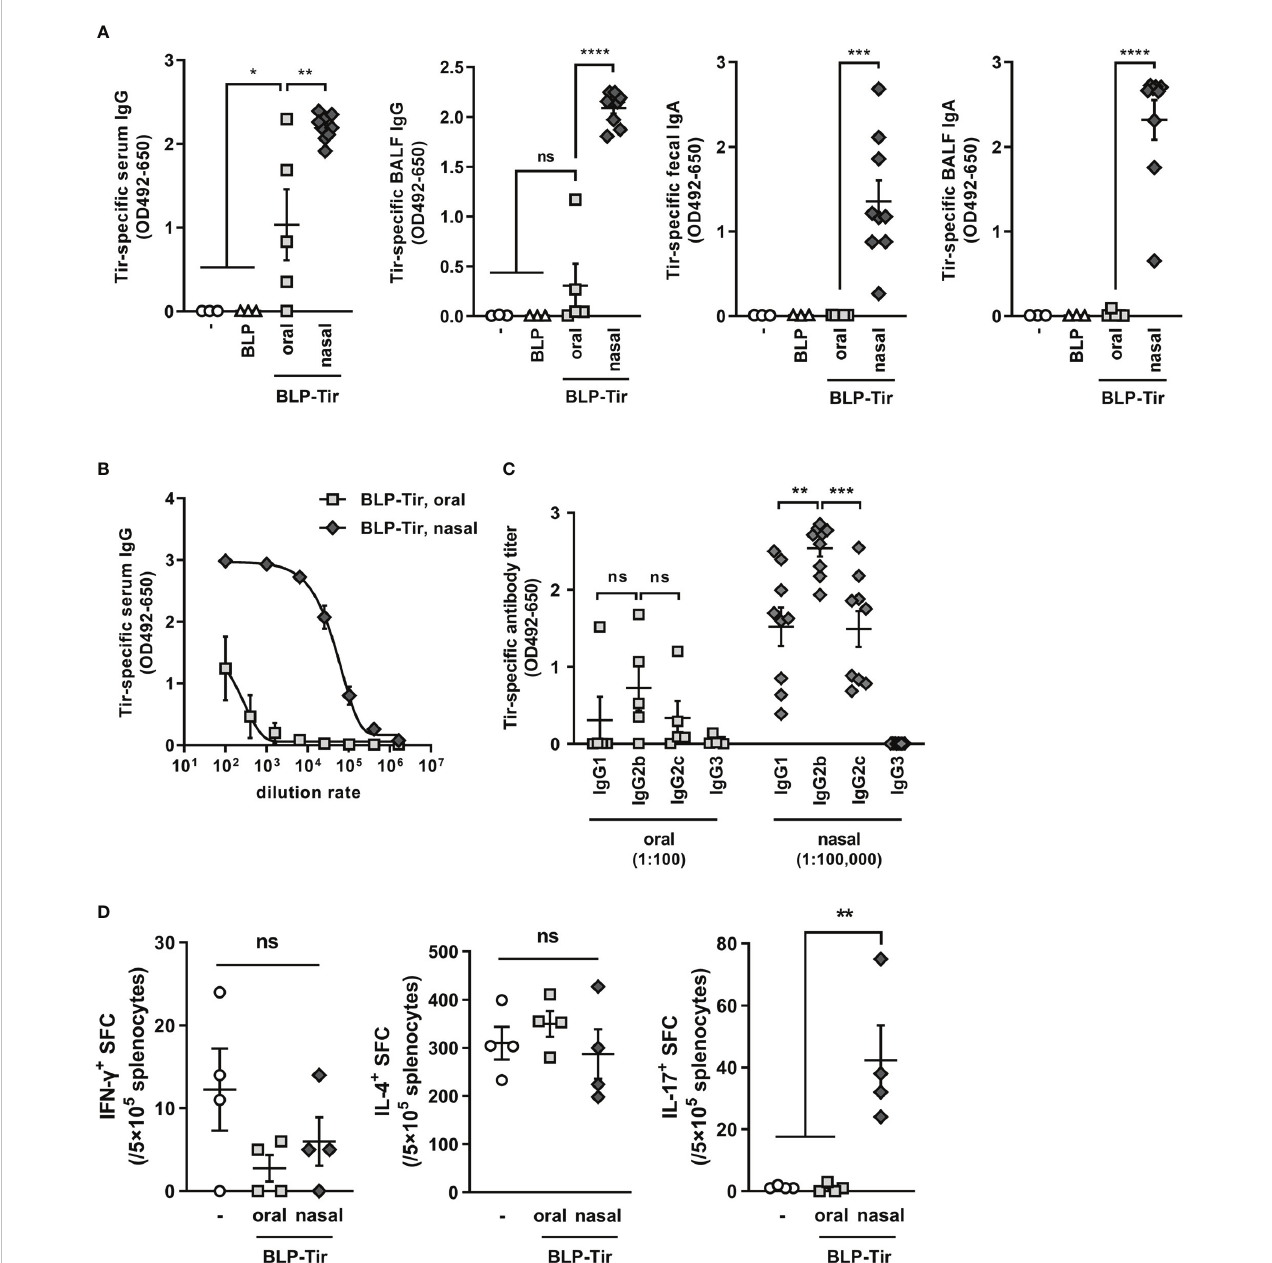
FIGURE 2 Tir-speci fi c humoral and cellular immune responses induced by oral or nasal administration of BLP-Tir. Mice were administered with BLP-Tir via the oral or nasal route for 3 consecutive days for 3 times (d0-2, d13-15, d27-29). (A) Tir-speci fi c IgG and IgA in serum, BALF, and fecal extracts collected at d35 were measured. The dilution rate of serum, BALF and fecal extract were 1:100, 1:2, and 1:3, respectively. Data were expressed as the mean ± SEM (n=3- 9). Each symbol represents an independent mouse. *, p<0.05; **, p<0.01; ***, p<0.001; and ****, p<0.0001; ns, not signi fi cant; one-way ANOVA followed by Tukey ’ s multiple comparison test. (B) , Tir-speci fi c serum IgG antibody titers of the same samples used in (A) were measured at various dilution rates. Data were expressed as the mean ± SEM (n=5-9). Some error bars are behind the symbols due to small variations. (C) , Tir-speci fi c IgG1, 2b, 2c, and 3 titers. Sera from mice orally administered with BLP-Tir (oral) were diluted 1:100 and those from mice nasally administered with BLP-Tir (nasal) were diluted 1:100,000 (n=5-9). Each symbol represents an independent mouse. **, p<0.01; ***, p<0.001; ns, not signi fi cant; one-way ANOVA followed by Tukey ’ s multiple comparison test. (D) , Mice were orally or nasally immunized with BLP-Tir. Splenocytes were isolated 30 days after the last administration. The number of IFN- g -, IL-4-, and IL-17-spot-forming cells (SFC) calculated from the ELISPOT assay after 30 m g/ml puri fi ed Tir stimulation in vitro . Data were expressed as the mean ± SEM (n=4). Each symbol represents an independent mouse. **, p<0.01; one-way ANOVA followed by Tukey ’ s multiple comparison